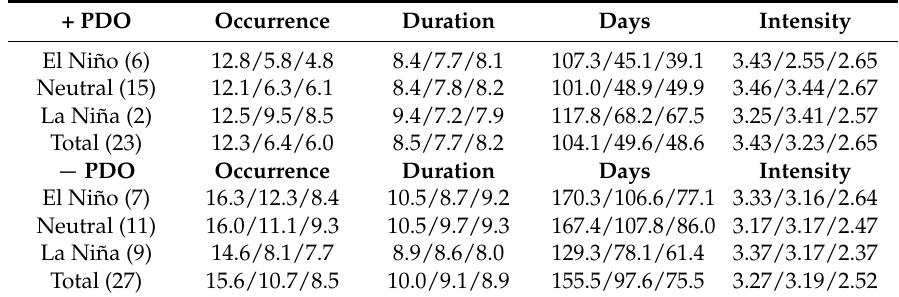
Table 5. Character of NH blocking events per year by region (ATL/PAC/CON) as a function of ENSO and PDO. The number of years in each category is shown in parenthesis. The values highlighted in red show variability similar to the overall values in Table 4.